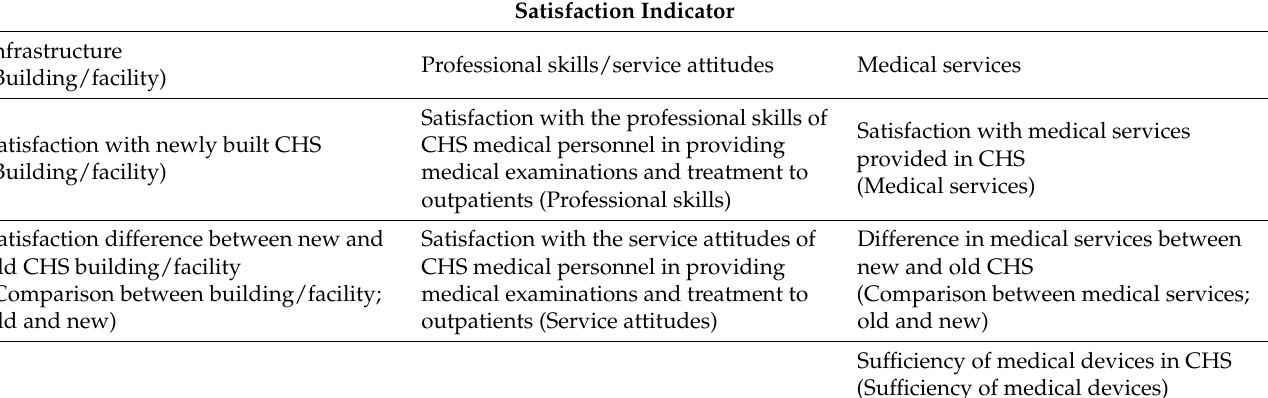
Table 1. Key inquiry into the three participant satisfaction indicators for the medical milieu offered by the